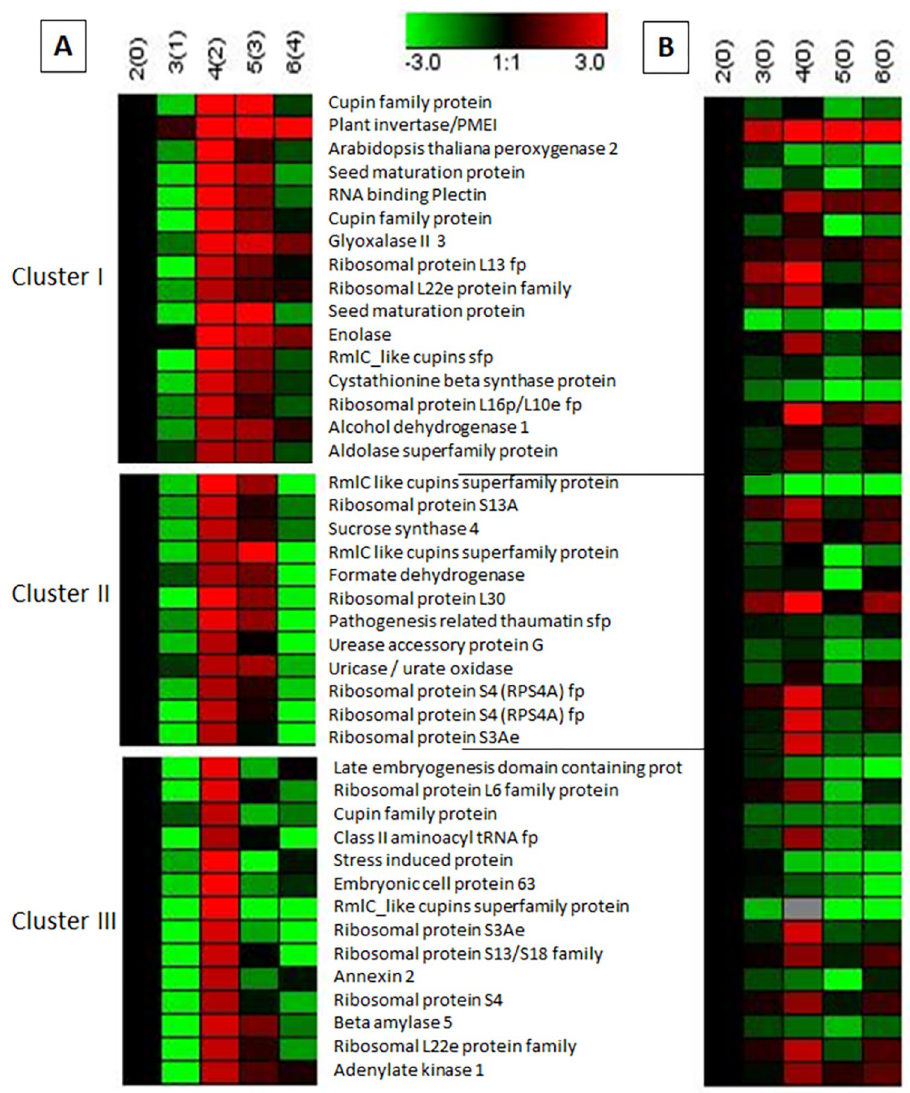
Fig 4. Cluster analysis of flooding-responsive proteins in flooded (A) and control (B) soybean roots using Genesis software.